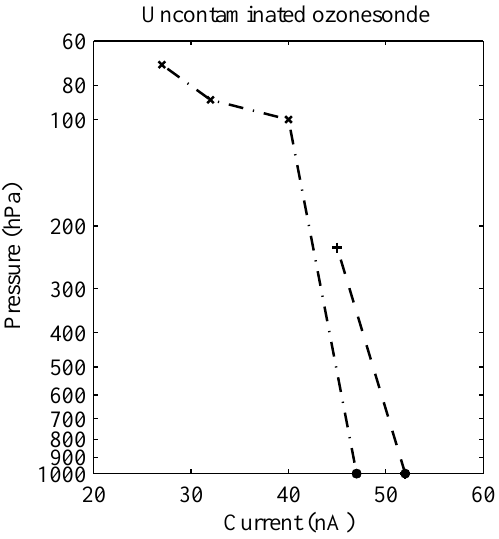
Figure A3. Figure showing the current measured at each pressure for the uncontaminated ozonesonde. The sonde was tested up to 250hPa in the first experiment (dashed line), before being brought back to surface pressure and then tested up to 70hPa (dash-dot line). Only the data points that simulate ascent are